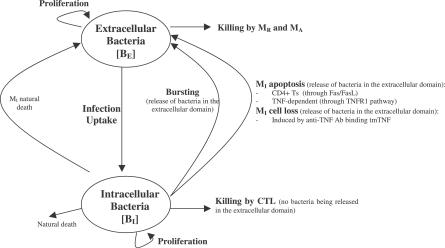
Bacteria DynamicsDescriptive diagram of bacteria dynamics implemented in the mathematical model in Equations 15–16.